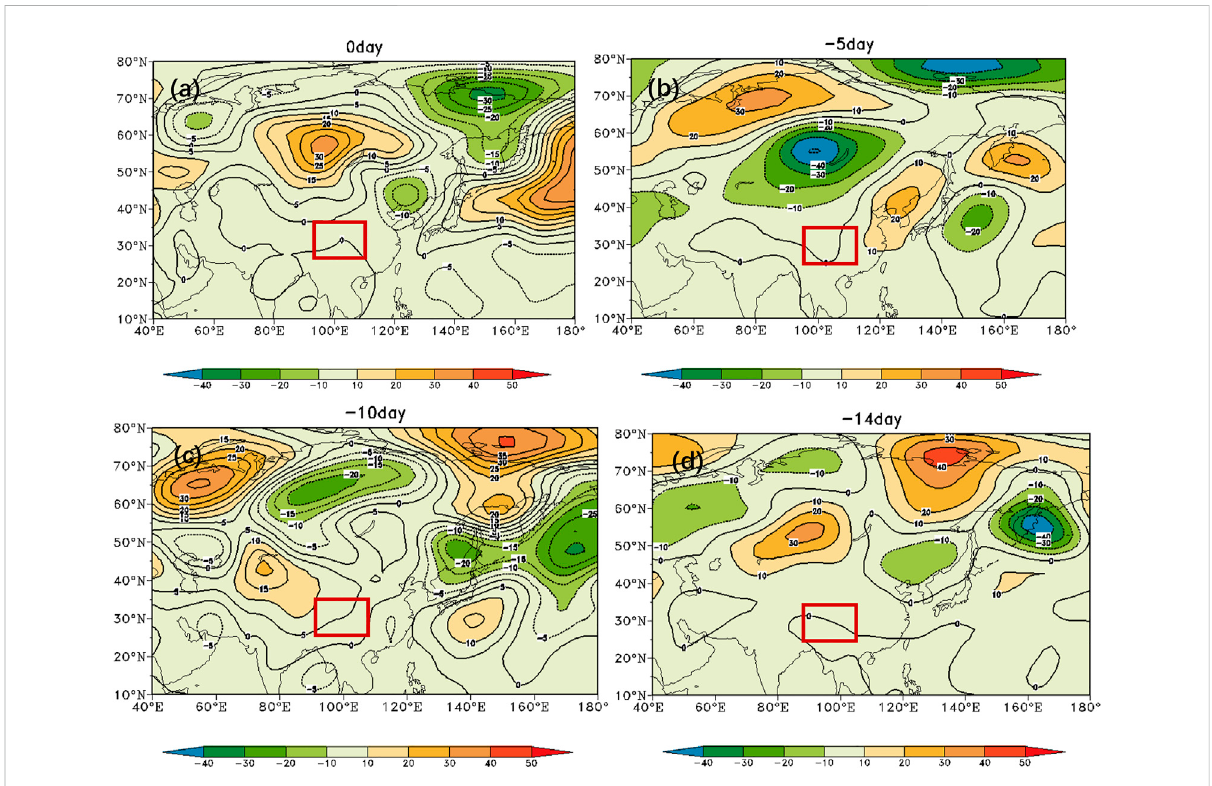
FIGURE 7 Evolutionofthelow-frequency(15 – 30 days)geopotentialheightanomalyat500 hPafrom14 daysbeforetheprecipitationto0 dayafteronset in western Sichuan, unit: